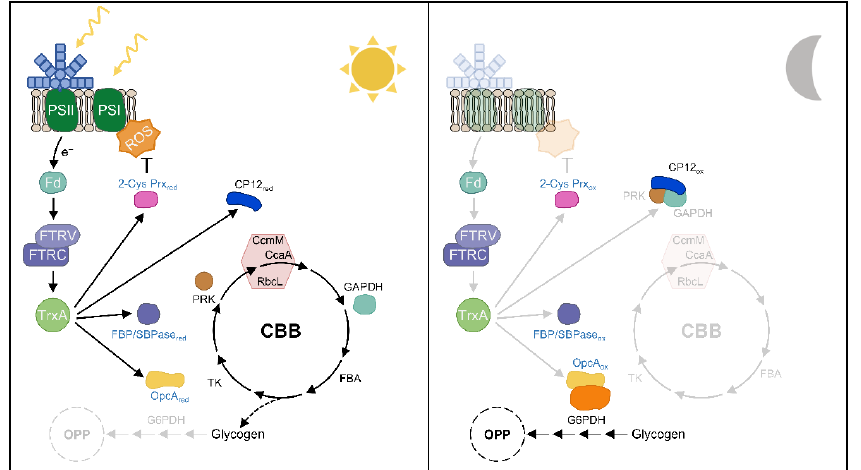
Figure 6. Snapshot of the role of TrxA on target proteins in day–night cycle. Reactions of the CBB cycle, redox homeostasis, and glycogen metabolism are represented. Enzyme names in blue are targets of Trx described in vivo. Enzyme names in black are targets of TrxA described in vitro. Abbreviations: PSI and PSII, photosystem I and II; ROS, reactive oxygen species; Fd,